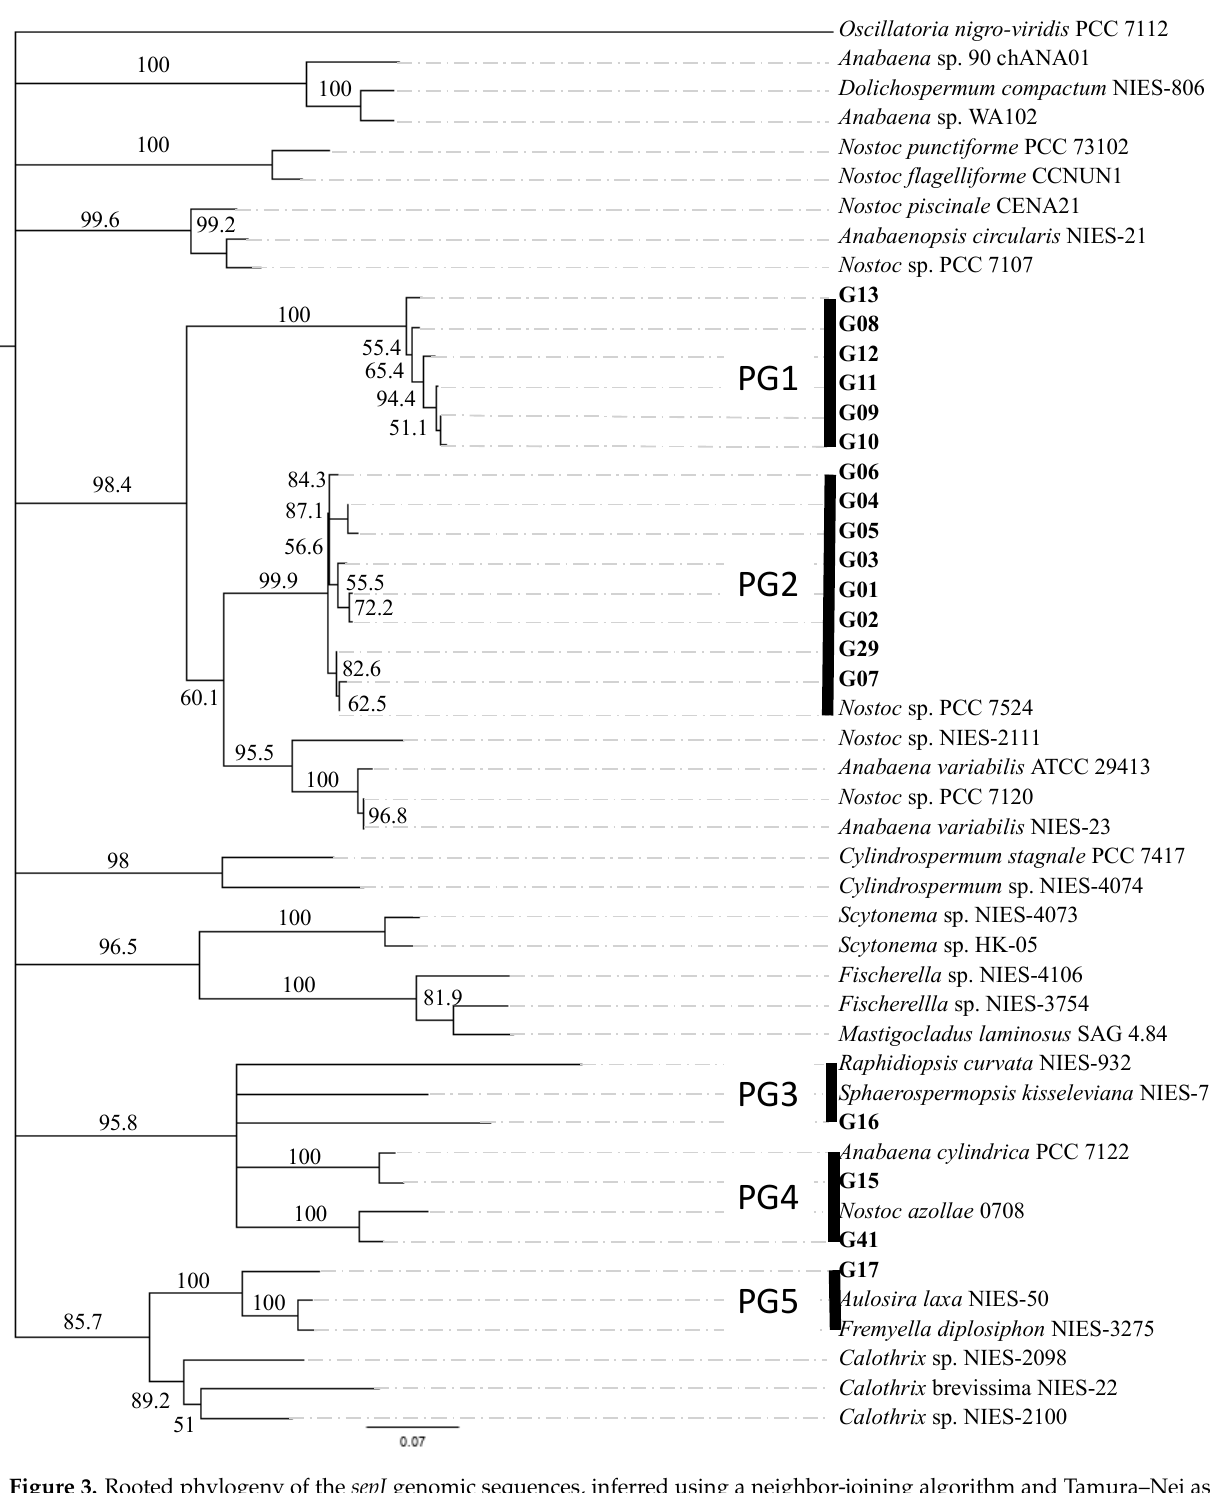
Figure 3. Rooted phylogeny of the sepJ genomic sequences, inferred using a neighbor-joining algorithm and Tamura–Nei as the distance genetic model using the bootstrap method ( n = 10,000). The bar represents 0.07 substitutions per site. Reference sequences were obtained from the GenBank nucleotide database, using the sequences experimentally amplified as template. Phylogenetic groups are highlighted.